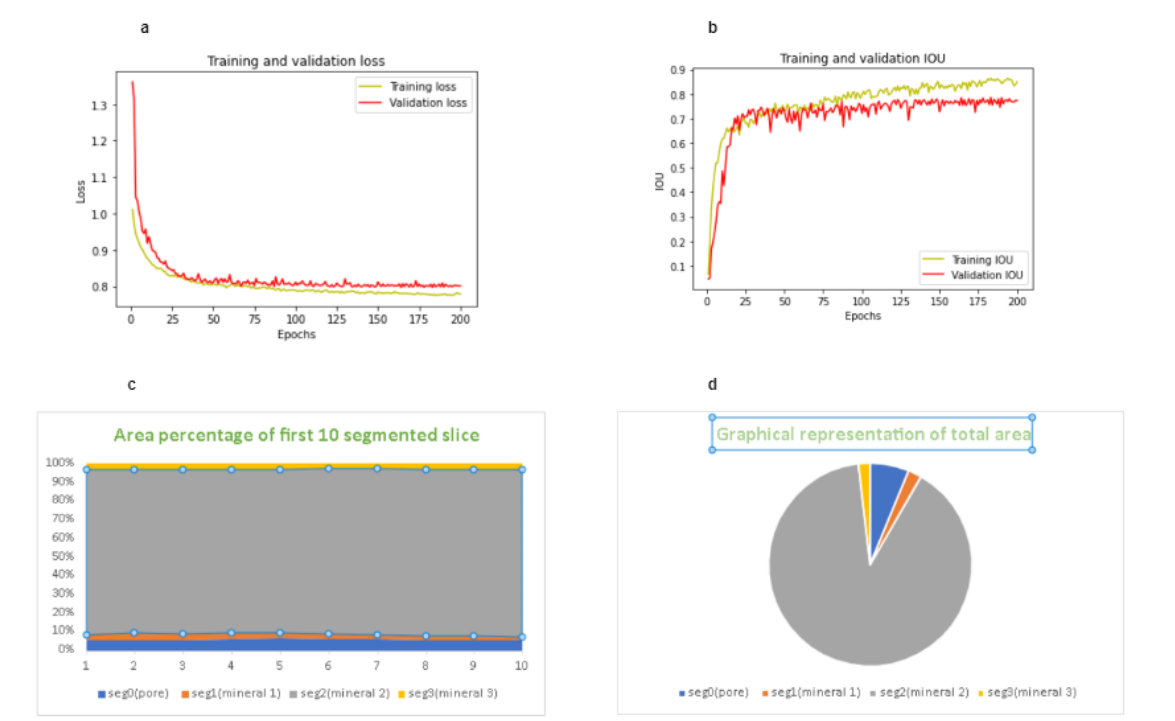
Figure 8. ( a ) Loss during training and testing as a result of the number of epochs. ( b ) IOU during training and testing as a result of the number of epochs. ( c ) Percentage of average area for each particle for the first 10 samples. ( d ) Representing the area of each particle